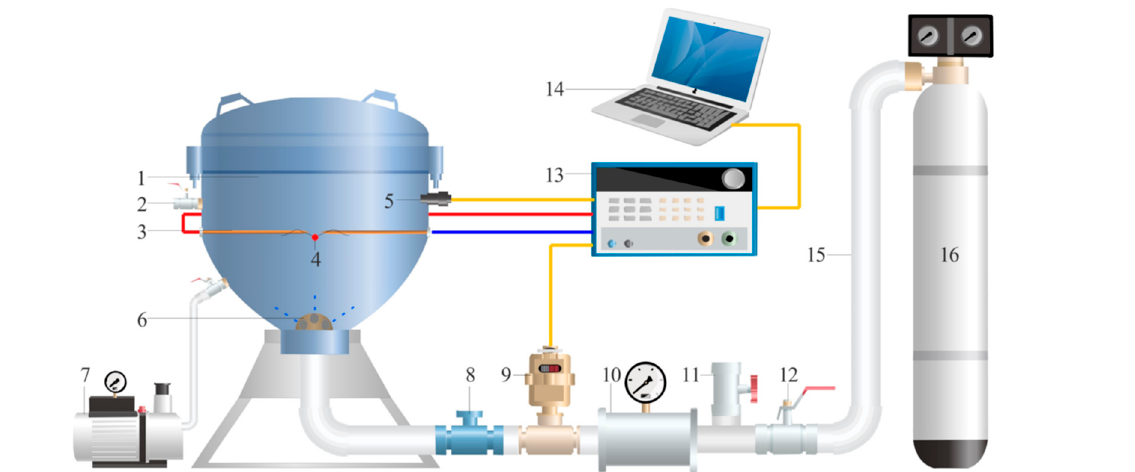
Figure 3. The 20 L spherical explosion test apparatus.